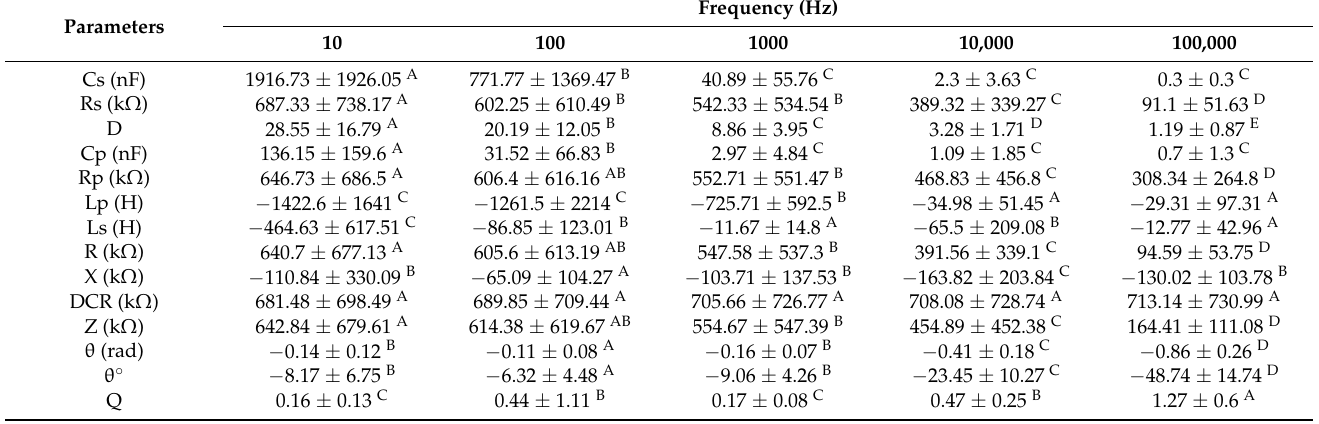
Table 3. Comparison of the mean values ± standard deviation of the electrical parameter of the stored date fruits under various testing frequencies. Where Cs is capacitance value (series equivalent circuit model), Rs is equivalent series resistance, D is dissipation factor, Cp is capacitance value (parallel equivalent circuit model), Rp is equivalent parallel resistance, Lp is inductance value (parallel equivalent circuit model), Ls is inductance value (series equivalent circuit model), R is resistance, X is reactance, DCR is direct current resistance, Z is the absolute value of impedance, θ (rad) is phase radian, θ ◦ is phase angle, and Q is the quality